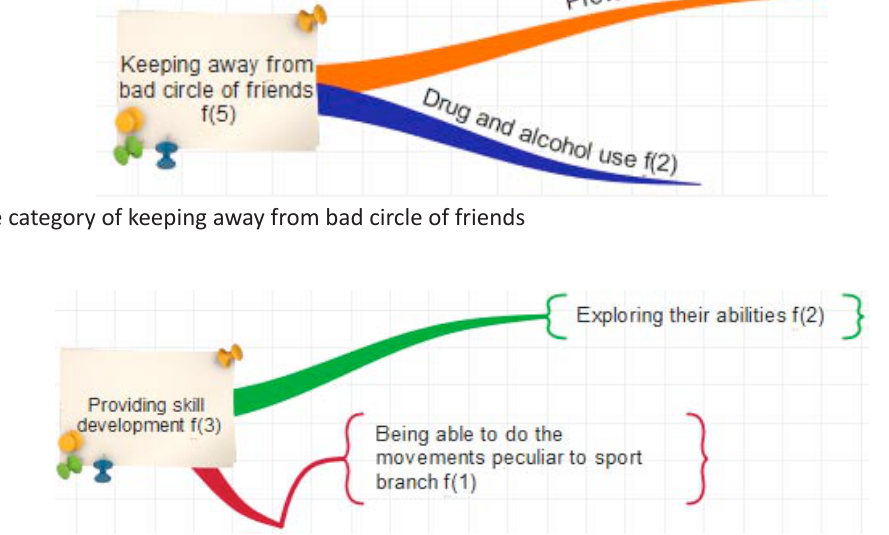
Figure 5. The category of providing skill